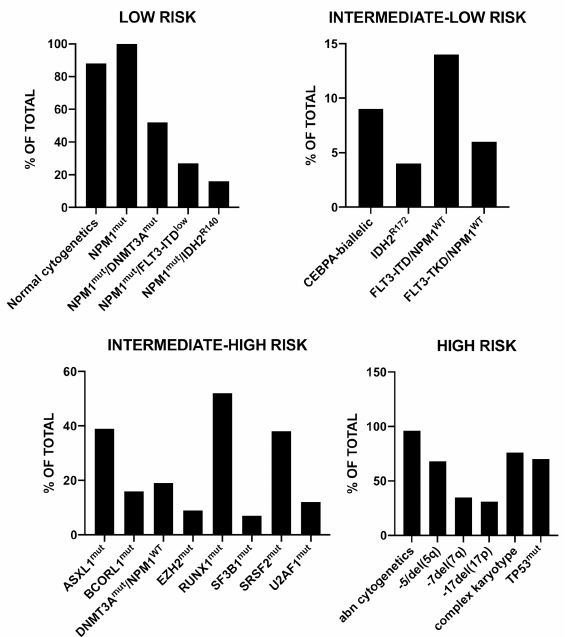
Figure 1. Recurrent gene mutations observed in a group of 3421 AML patients subdivided into three prognostic risk groups (low risk, intermediate risk and high risk), according to a machine learning algorithm accounting for survival. The data are reported in Shreve et al., 2019 [30]. Abbreviations: mut: mutant; del: deletion; abn: